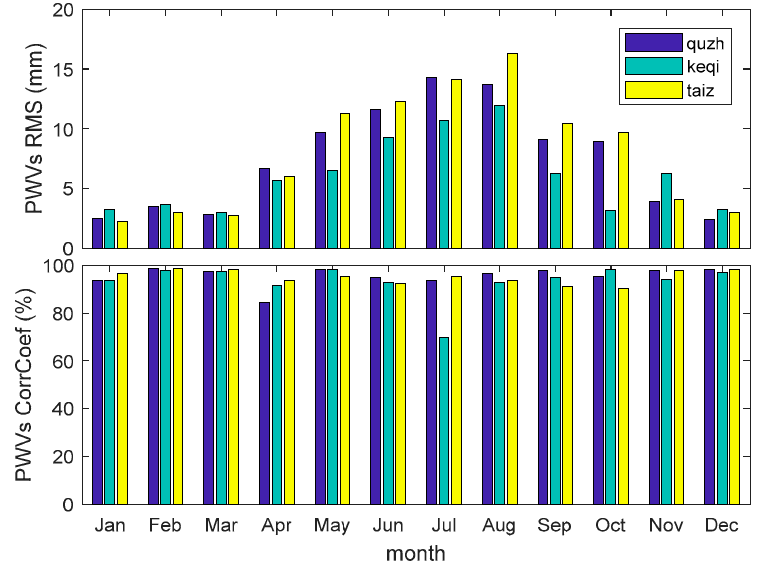
Figure 7. The RMS of GPS PWV and radiosonde PWV differences (top panel) and GPS and radiosonde PWVs correlation coefficient (bottom panel) every month in 2016.